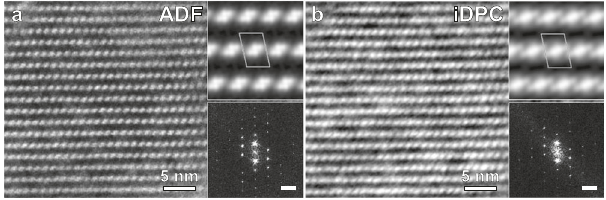
Fig. 3 STEM images of a highly ordered section of a BSS-PB crystal along [100]. a Annular dark fi eld (ADF) scanning transmission electron microscopy (STEM) image. b Integrated differential phase contrast (iDPC) STEM image. Lattice-averaged maps with p2 symmetry imposed and fast Fourier transforms (scale bar is equal to 0.1 Å − 1 ) are shown as insets for each